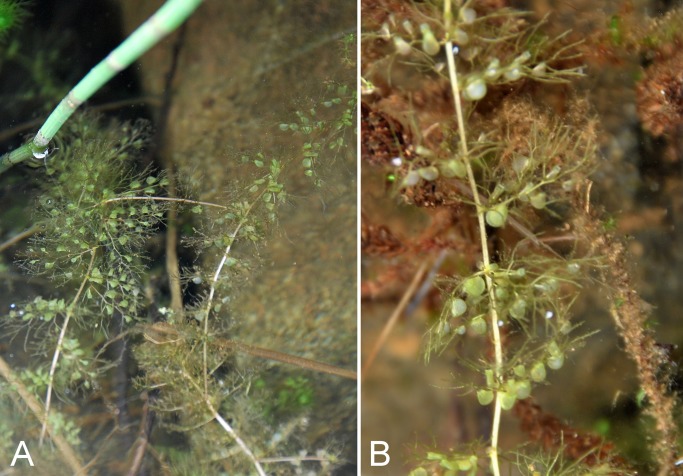
Utricularia vulgaris.(A) Habit, Saarela et al. 3877. (B) Bladders, Saarela et al. 3877. Photographs by J. M. Saarela.